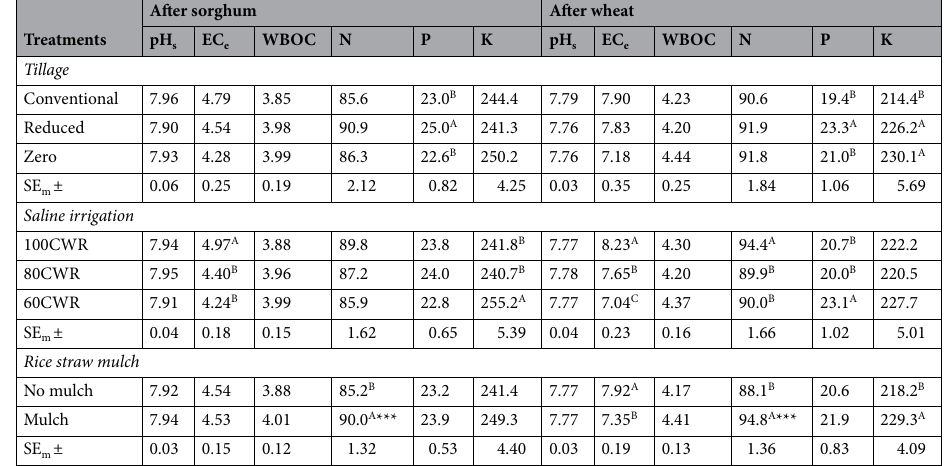
Table 1. Influence of tillage, irrigation and mulch on soil pH s , EC e (dS m −1 ), Walkley and Black oxidizable organic C (WBOC; g kg −1 ) and KMnO 4 oxidizable N, Olsen’s P and NH 4 OAc extractable K (kg ha −1 ). Different uppercase letters (A, B) denote significant differences (** P < 0.01, *** P < 0.001, Tukey’s HSD test). Data are means over 2 years. CWR: Percent water requirement for wheat, irrigation applied only in wheat, sorghum was grown as rainfed; SE m ± : standard